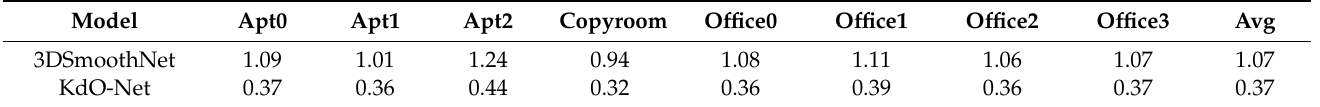
Table 1. Average nearest neighbor searching time per interest point on each scene of BundleFusion training set (ms).